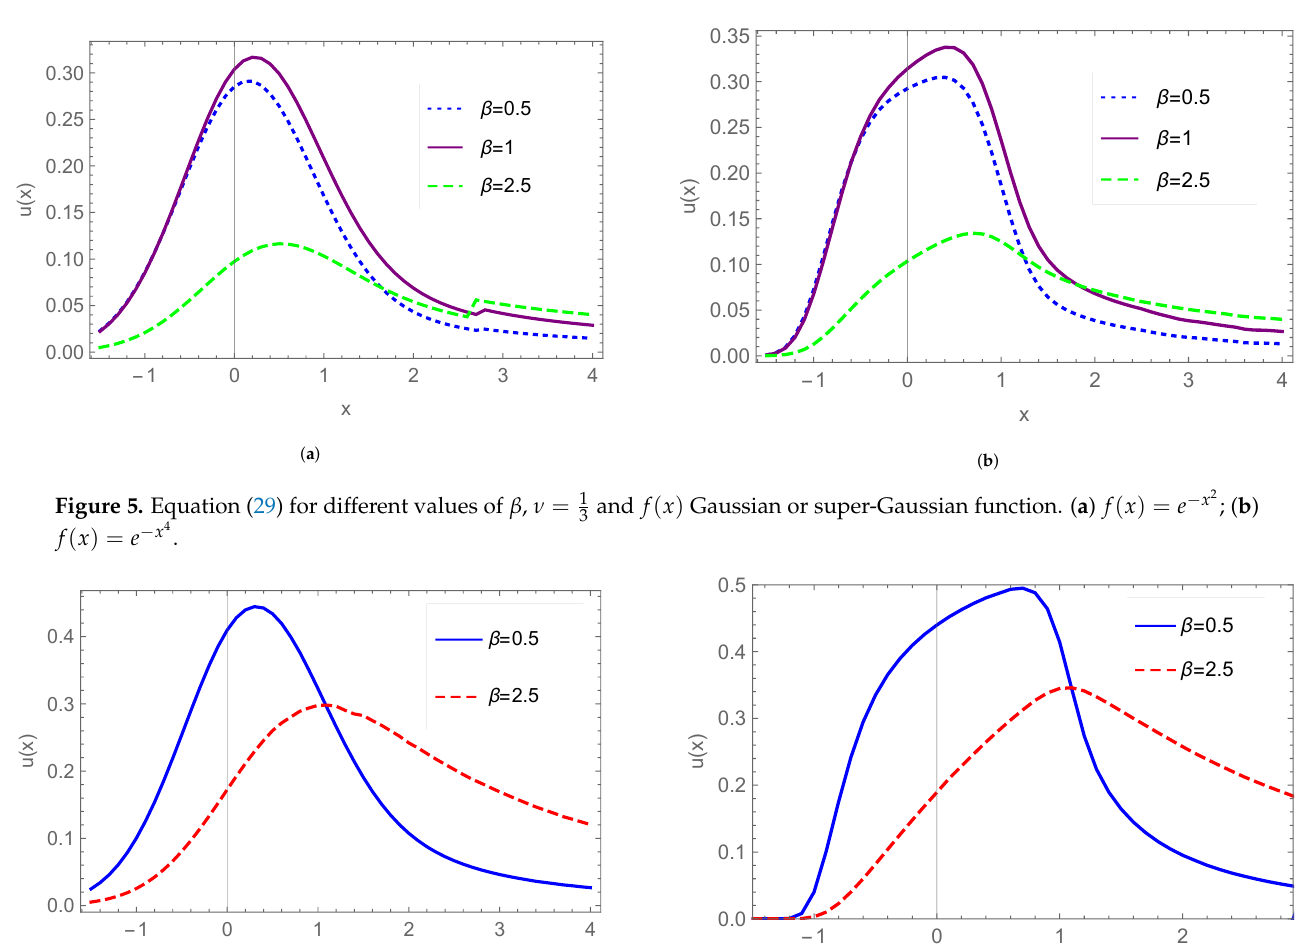
and f ( x ) Gaussian or super-Gaussian function. ( a ) f ( x ) = e − x 2 ; ( b ) 3